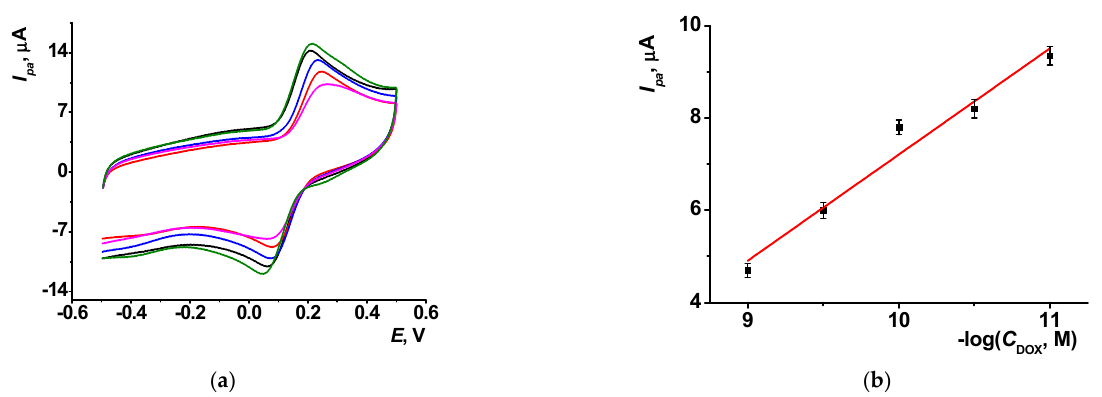
Figure 9. ( a ) Cyclic voltammograms of 0.5 mM hydroquinone recorded on the GCE covered with CB and 50 μ M TC mixed with 0.1 mg/mL DNA after its 10 min incubation in 10, 3.0, 1.0 pM, 3.0 and 1.0 nM doxorubicin; ( b ) calibration curve of doxorubicin, average ± S.D. for five electrodes.